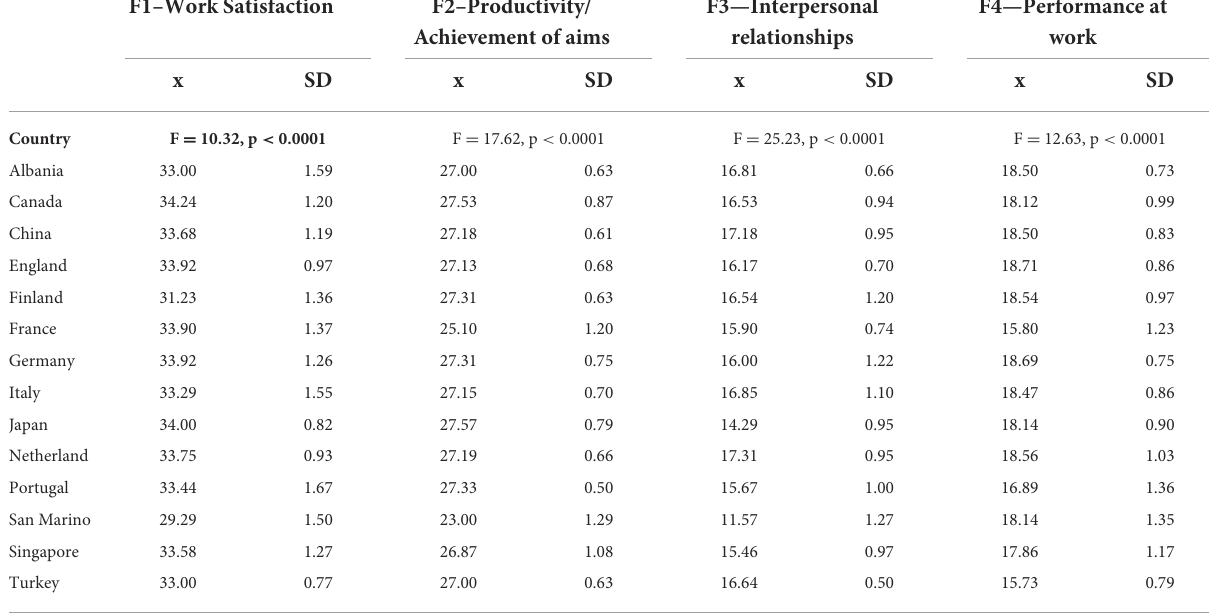
TABLE 3 Correlations between factors 1–4 and the countries included in the study. F1–Work Satisfaction F2–Productivity/ Achievement of